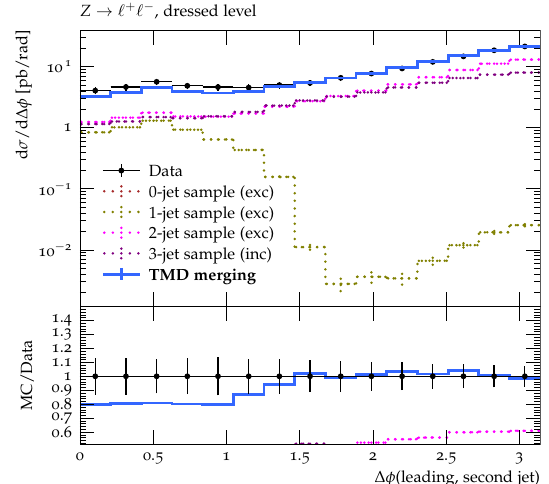
Figure 14 . Di-jet azimuthal separation distribution for Z + ≥ 2 jets events. Experimental mea- √ surements by ATLAS [91] at s = 13 TeV are compared to predictions using the TMD merging calculation. Separate contributions from the different jet samples are shown. All the jet multiplic- ities are obtained in exclusive (exc) mode except for the highest multiplicity which is calculated in inclusive (inc)